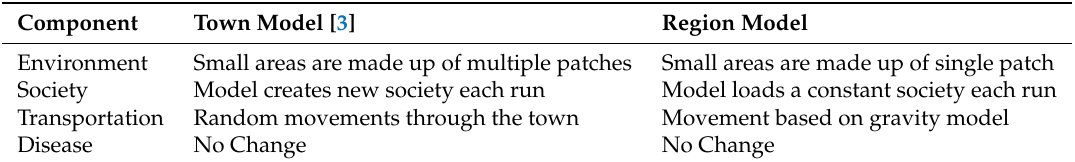
Table 4. Differences between the Hunter et al. [3] town model and the scaled up region model by component of the